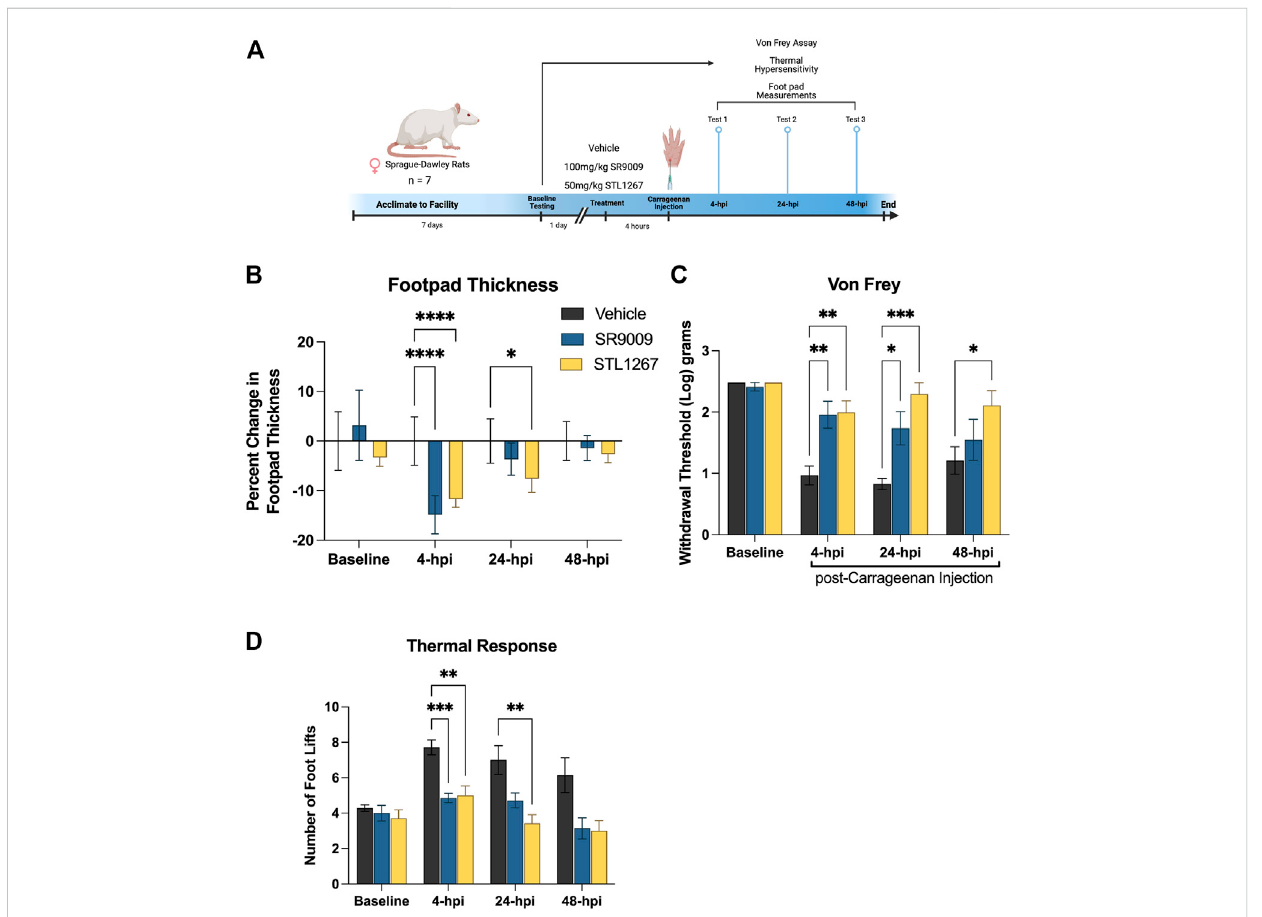
REV-ERB agonists suppress pain behavior in a rat model of acute in fl ammatory pain. (A) Schematic of the rat model used to evaluate the ef fi cacy of REV-ERB agonists SR9009 and STL1267 in acute in fl ammatory pain. (B) Measurement of the in fl ammatory response following a single injection of REV- ERBagonist(i.p.)andcarrageenaninjectionintherathindpaw.Measurementsweretakenwithadigitalcaliperandnormalizedasthechangeinthickness asapercentagetothebaselinemeasurements. (C) MechanicalhypersensitivitywasmeasuredusingaVonFrey fi lament. (D) Thermalhypersensitivity was also tested on these animals following a single injection of REV-ERB agonist (i.p.) and evaluated by recording the number of foot lifts over a 30-s interval. Data was analyzed in Graphpad Prism using ANOVA with Dunnett ’ s post-hoc test and represented by Mean ±